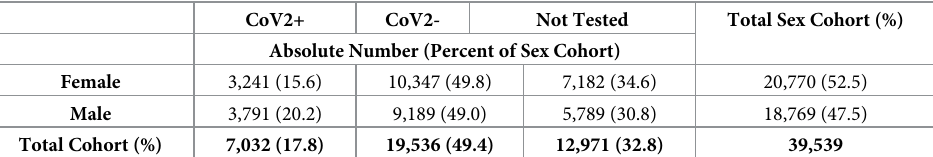
Table 3. CoV2 testing distribution across